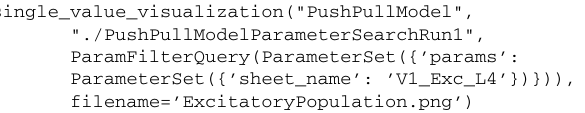
excitatory and inhibitory synapses in the network. For each combination of values of these two parameters the network’s mean firing rate and mean square of coefficient of variation of inter-spike intervals (CV of ISI) were calculated, thus providing a single value measure for each network parameterization. The plot on the left shows the mean firing rate as a function of the varied parameter values, while the plot on the right shows the mean square of CV of ISI